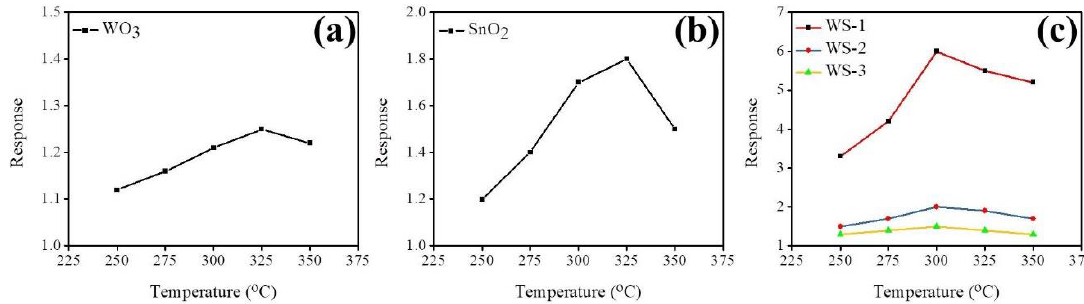
Figure 7. Temperature-dependent gas-sensing responses for the gas sensors on exposure to 100 ppm acetone vapor at operating temperatures ranging from 250 to 350 °C: ( a ) WO 3 nanorods, ( b ) SnO 2 thin film, ( c ) various composite nanorods: WS-1 (red line), WS-2 (blue line), and WS-3 (yellow line).